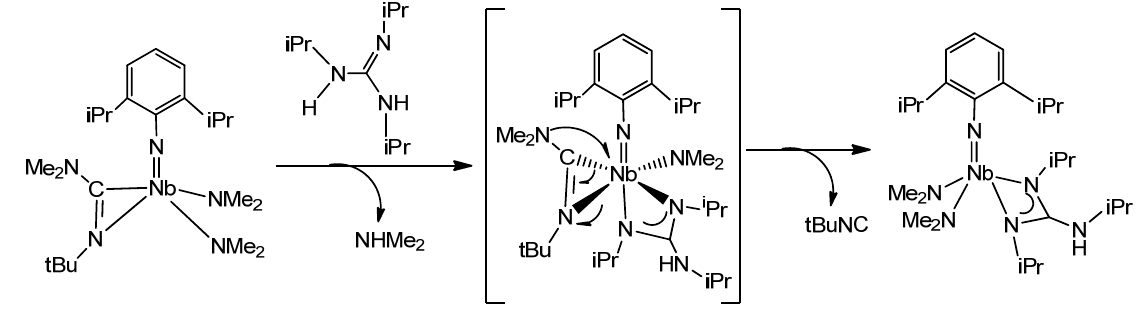
Figure 34. C–N activation mediated by a guanidine in an iminocarbamoyl compound.